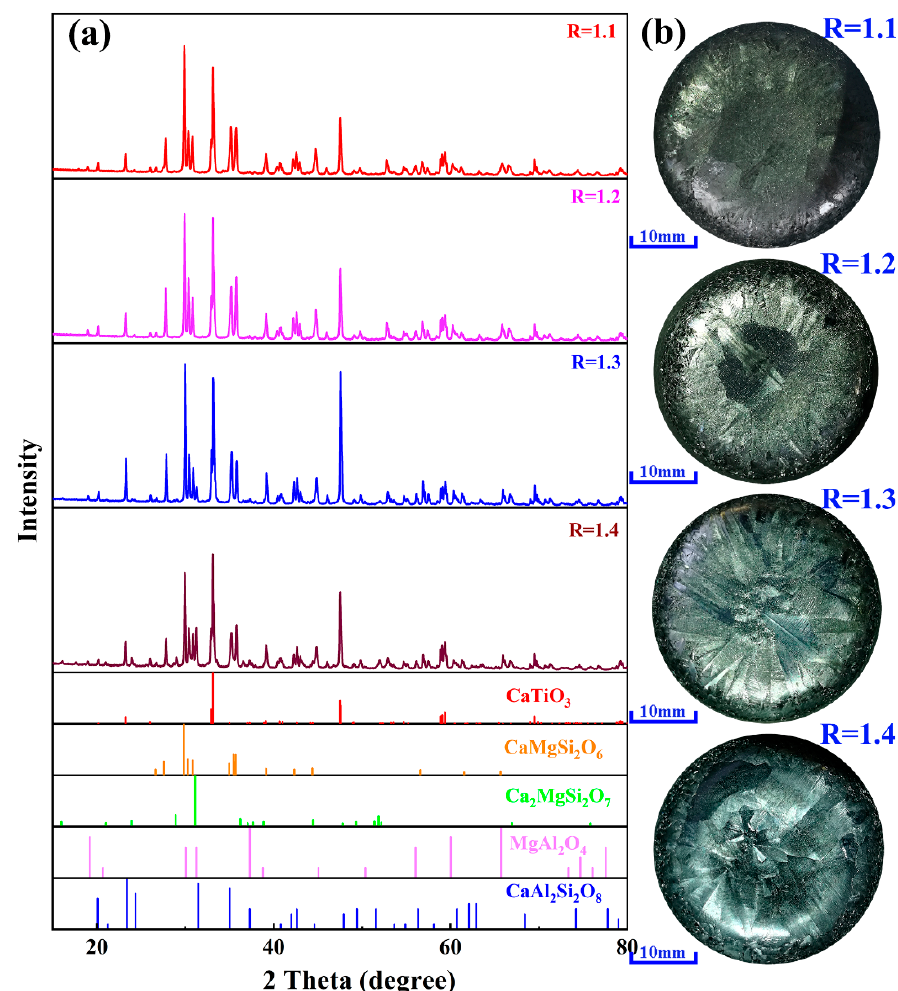
Figure 3. ( a ) X-ray Diffraction (XRD) patterns, and ( b ) the surface morphologies of the samples after cooling.